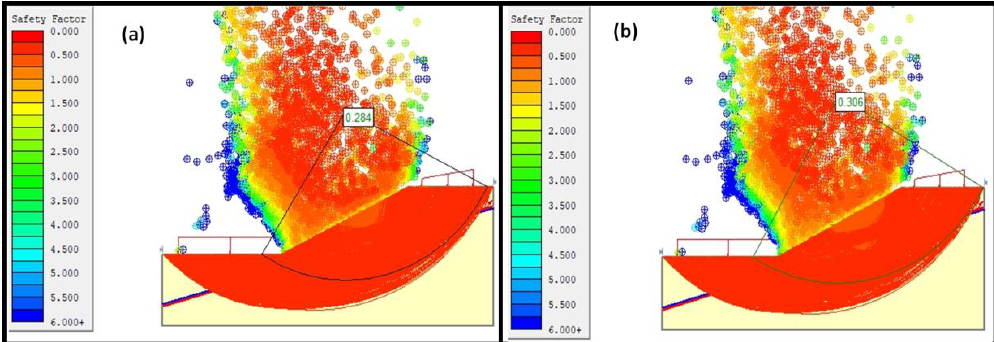
Figure 19. Safety factor simulated for rainy conditions in silt clay soil slope using ( a ) Bishop’s simplified method and ( b ) Janbu’s simplified method .